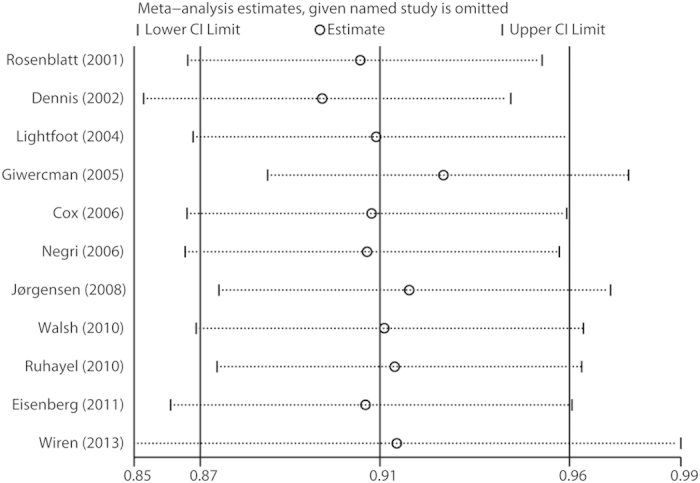
Sensitivity analysis was performed by excluding each study in turn and recalculating the pooled estimates.